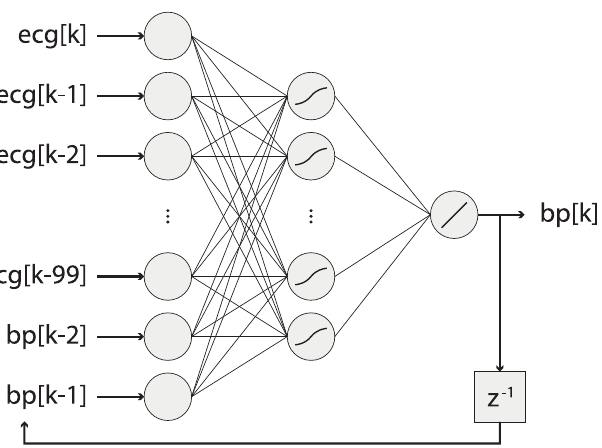
Figure 2. The NARX model for BP estimation is a multilayer perceptron with one hidden layer that feeds back its output to the input of the network. The hidden layer has a hyperbolic tangent activation function and the output layer has a linear activation function.